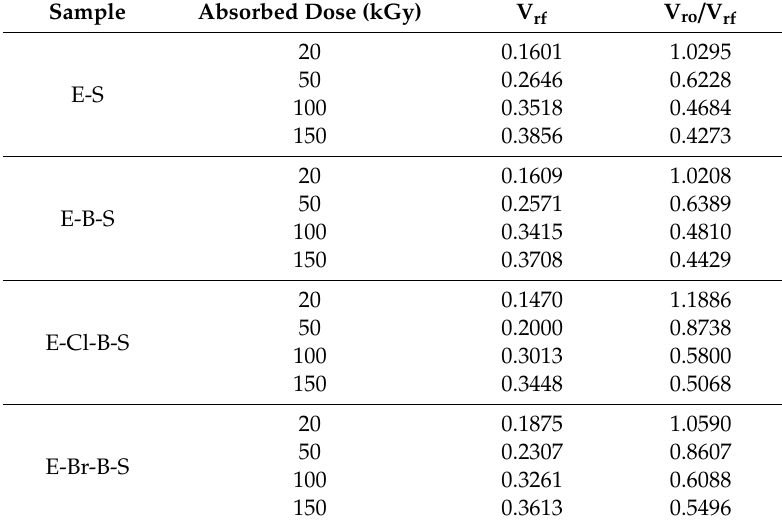
Table 2. V rf and V ro / V rf values of EPDM / butyl rubber / nanosilica composites in toluene.